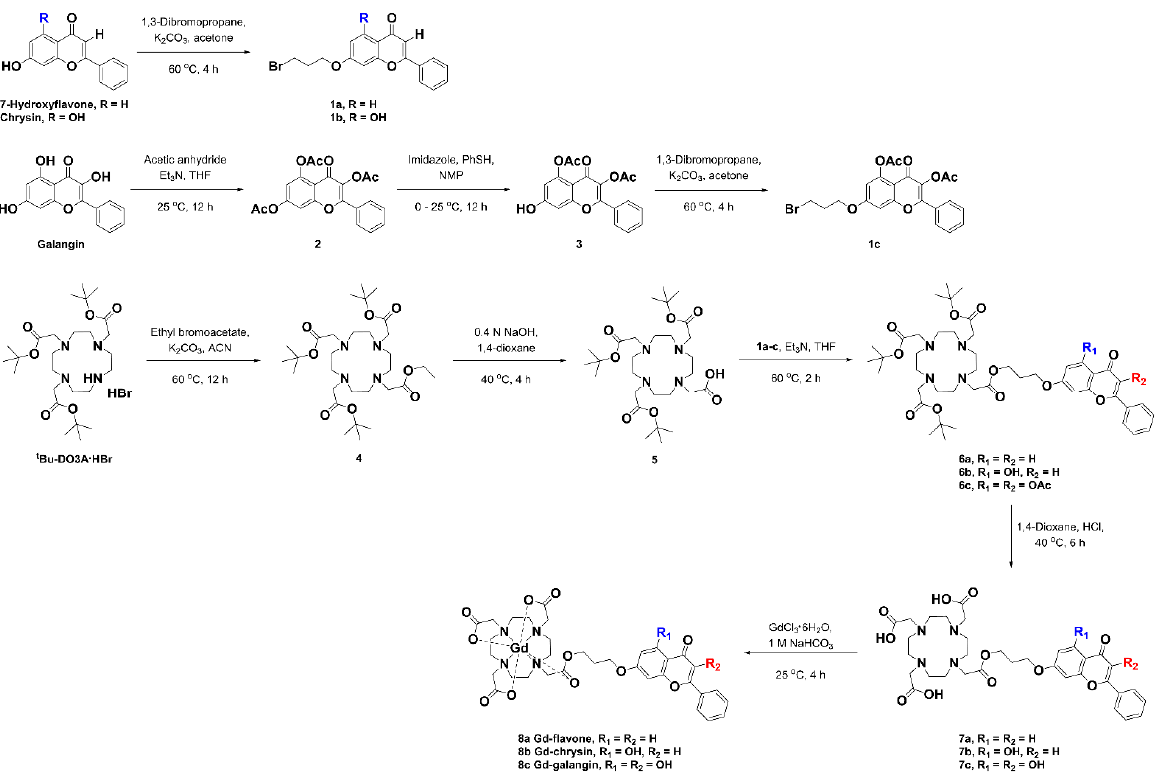
Figure 1. Synthesis of the gadolinium complexes of the DO3A conjugated with 7-hydroxyflavone, chrysin and galangin. Abbreviations: triethylamine (Et 3 N), tetrahydrofuran (THF), thiophenol (PhSH), 1-methyl-2-pyrrolidone (NMP), acetonitrile (ACN).